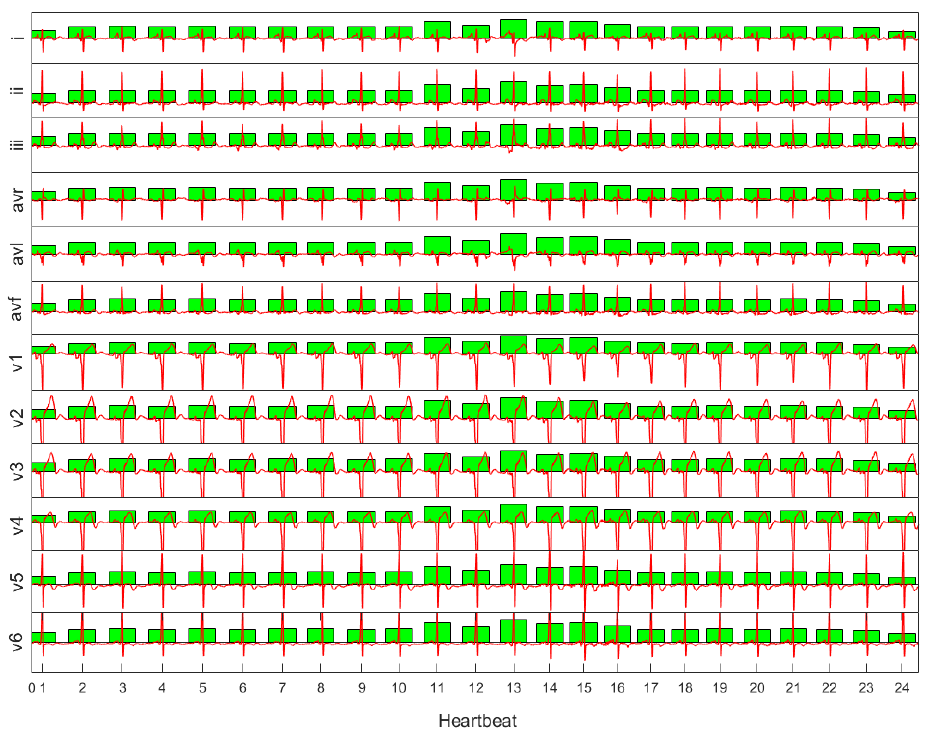
Figure 7. Weights assigned for di ff erent heartbeats in ECG records.